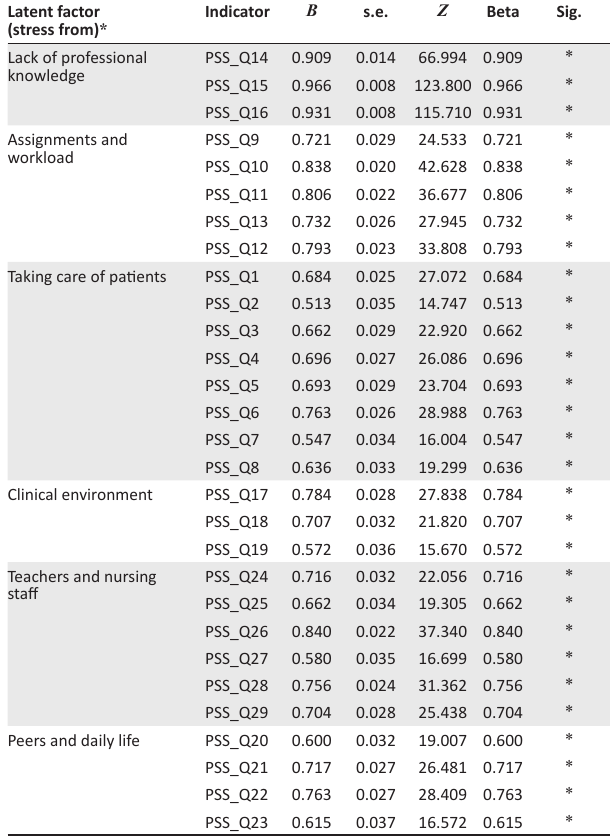
TABLE 4: Descriptive statistics for observed variables. Scales and variables †